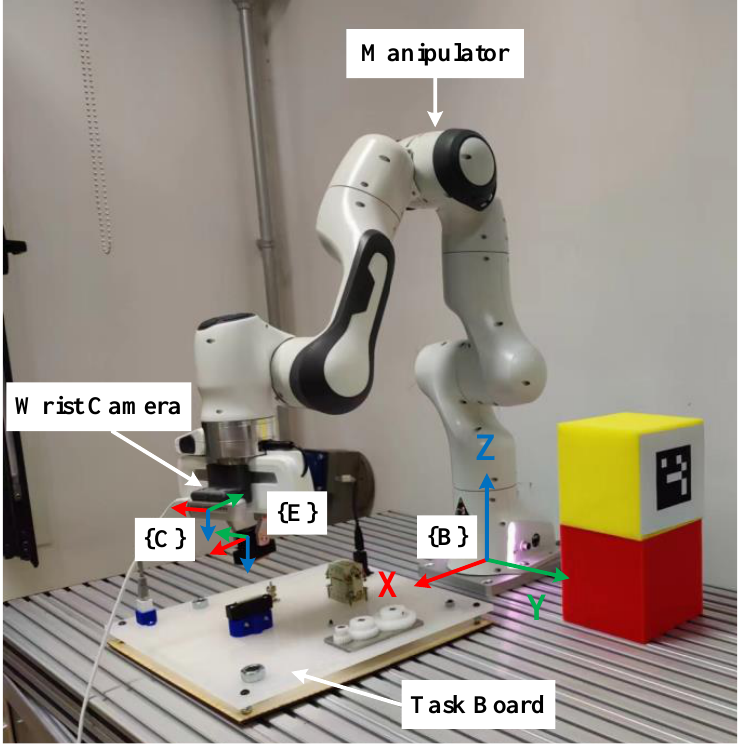
Figure 12. The peg-in-hole assembly platform.